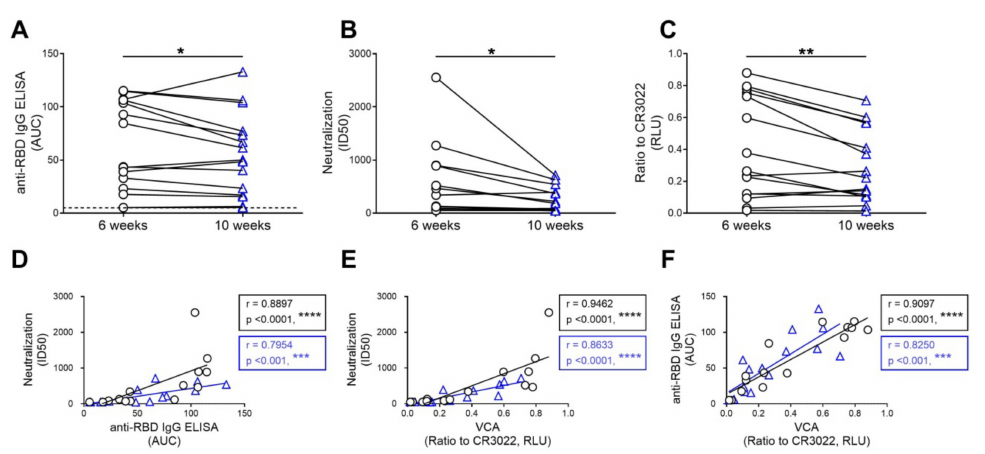
Figure 3. The capacity of convalescent plasma to bind to the S glycoprotein of SARS-CoV-2 and neutralize pseudoviral particles decreases over time. Convalescent plasma samples recovered six (black circle) and ten (blue triangle) weeks after symptoms onset from fifteen individuals were used for ( A ) anti-SARS-CoV-2 RBD IgG ELISA, ( B ) neutralization against pseudoviral particles expressing the SARS-CoV-2 S glycoprotein, and ( C ) virus capture assay (VCA). ( A ) Anti-RBD antibody binding was detected using anti-IgG-HRP. Relative light units (RLU) obtained with BSA (negative control) were subtracted and further normalized to the signal obtained with the anti-RBD CR3022 mAb present in each plate. The areas under the curve (AUC) were calculated based on RLU using GraphPad Prism software. AUC below threshold (dashed line) was considered no binding. ( B ) Neutralization half-maximal inhibitory plasma dilution (ID 50 ) was determined using a normalized non-linear regression using Graphpad Prism software. ( C ) VSV-G-pseudotyped viral particles expressing the SARS-CoV-2 S glycoprotein were added to plates coated with plasma samples. Free virions were washed away, and Cf2Th cells were added to the wells. After 48 hours, cells were lysed, and the luciferase activity was measured. Luciferase signals were normalized to those obtained with the RBD-specific CR3022 antibody. Data shown are the mean ± SD of three independent experiments performed in triplicate. Statistical significance was evaluated using a paired t-test (*, p < 0.05, **, p < 0.01). Correlations between ( D ) neutralization and anti-RBD IgG ELISA, ( E ) neutralization and VCA, and ( F ) anti-RBD IgG ELISA and VCA were calculated. Correlations for samples recovered six weeks (in black) and